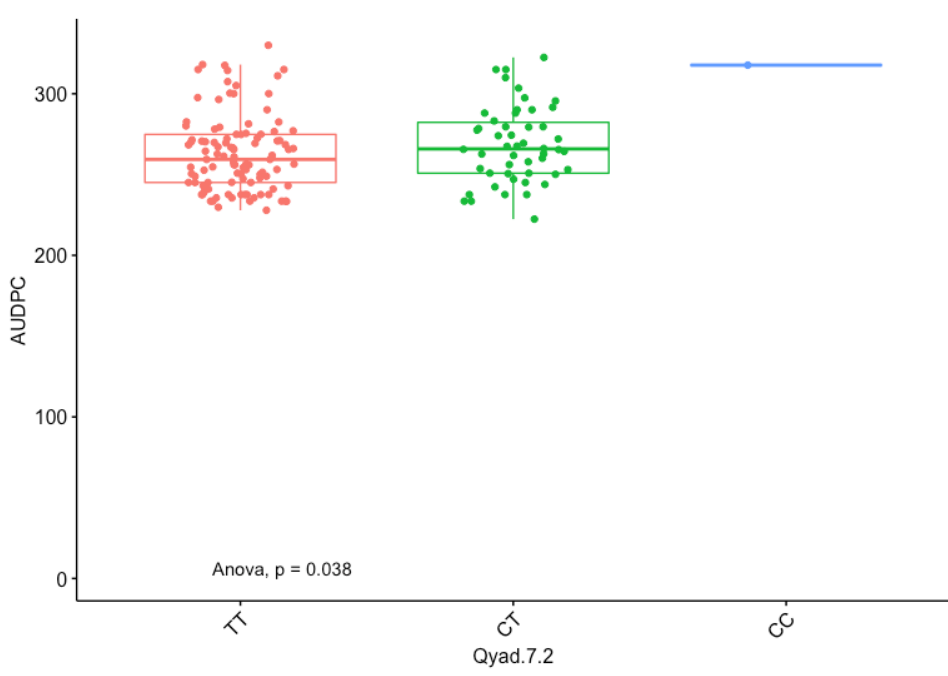
Figure 4. The boxplot displaying the effect of the different alleles (variants) of Qyad-7-2 on the AUDPC estimates. The letters on the X-axis represent alleles (CC, CT, and TT).